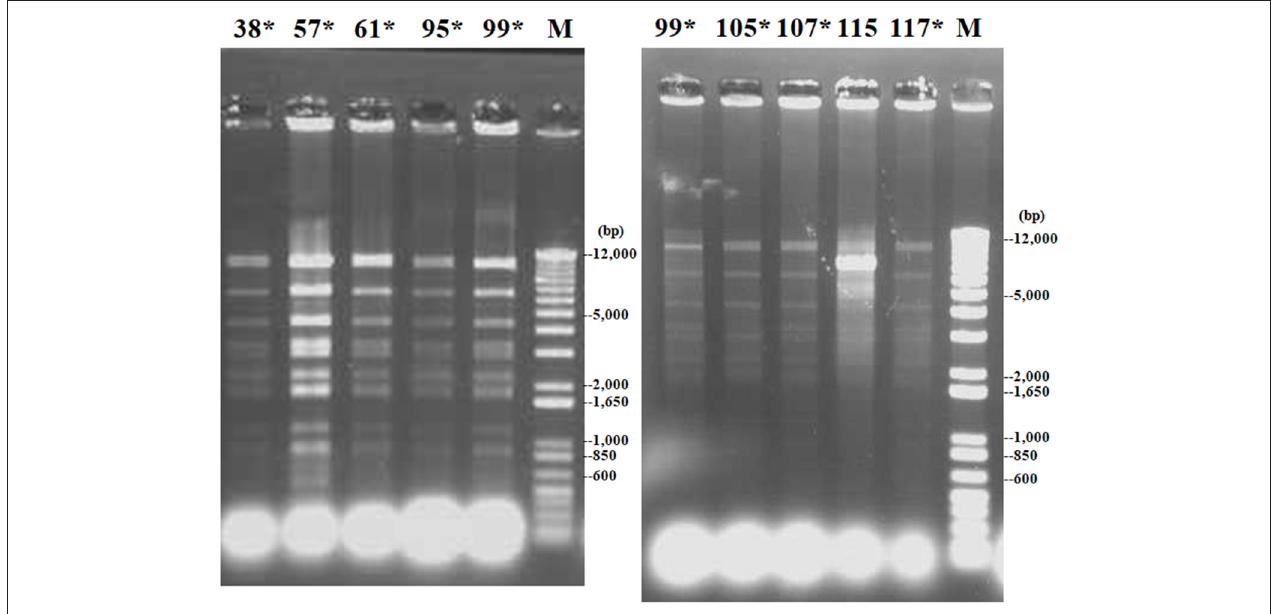
FIGURE 4 | Restriction fragment length polymorphism patterns of Dra I-digested plasmids of nine transconjugants received from donor strains of extended-spectrum β -lactamase (ESBL)-producing K. oxytoca . Lanes 38, 57, 61, 95, 99, 105, 107, 115, and 117: transconjugants received plasmids from strains Ko38, Ko57, Ko61, Ko95, Ko99, Ko105, Ko107, Ko115, and Ko117, respectively; lane M: molecular size standards. Asterisks represent identical restriction patterns.